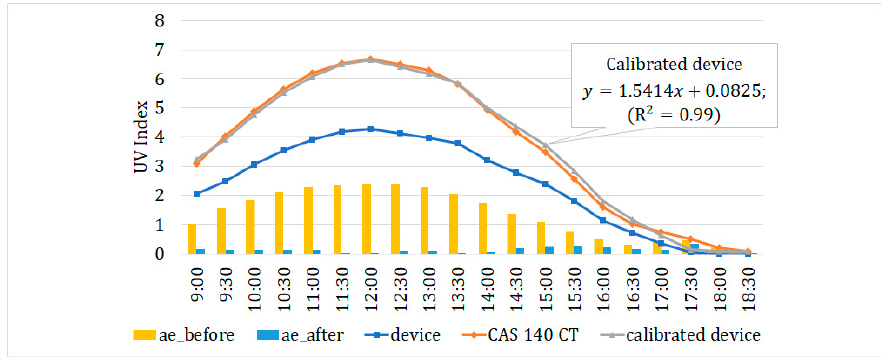
Figure 7. Performance test results of the measuring device.